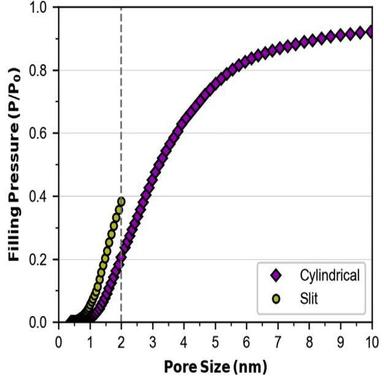
Equilibrium filling pressures for CO2 adsorption at 273.15 K in carbon pores. (A colour version of this figure can be viewed online.)